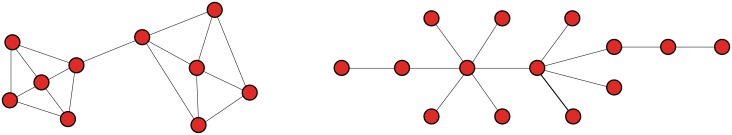
Two significant global structures observed in our experiments.On the left is the community structure typical of the stochastic blockmodel. On the right is the heavy-tailed degree distribution typical of the preferential attachment model.